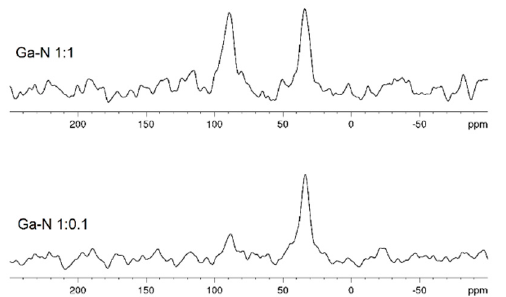
Figure 2. 15 N CPMAS NMR spectra of the sample Ga-N prepared with the Ga:APTMS ratio of 1:1 and 1:0.1, respectively.